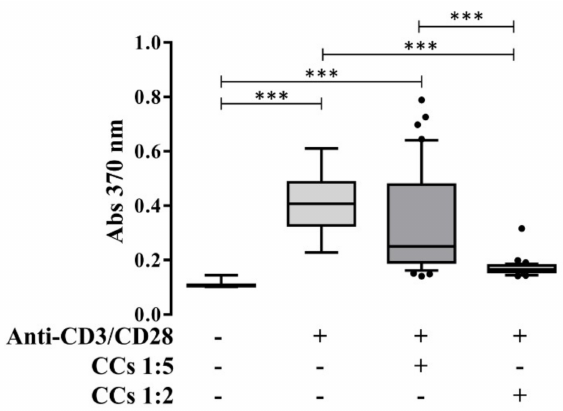
Figure 6. PBLs’ proliferation after interaction with CCs. Proliferation of PBLs in presence (+) or absence ( − ) of anti-CD3/CD28 and IL-1 β -treated CCs in a ratio of 1:2 or 1:5 (PBLs:CCs). *** p < 0.001. Data are expressed as mean ± SD ( n =